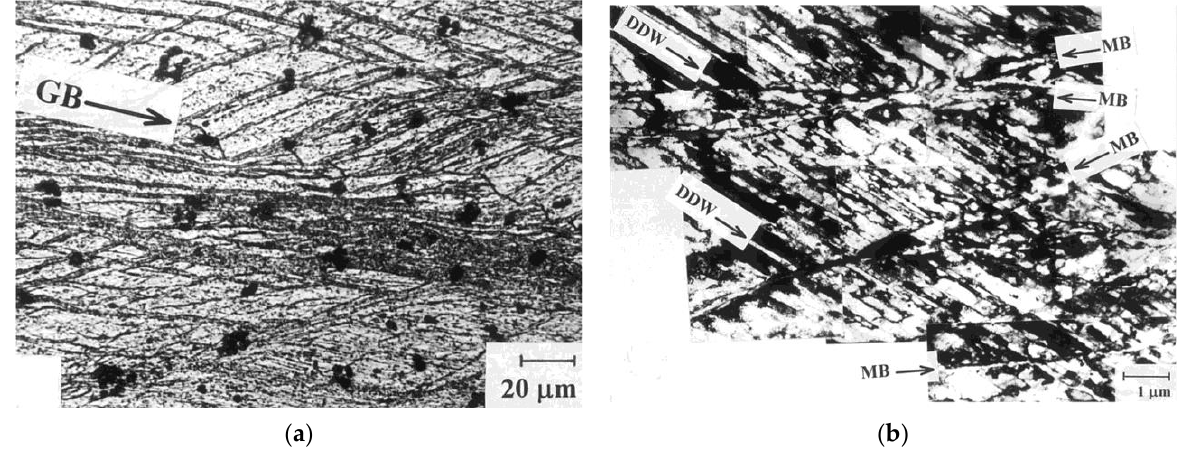
Figure 3. Microshear bands evolved near original grain boundary ( a ) and crossing dense dislocation walls ( b ) in a Fe-25%Cr steel after compression at 873 K to a strain of 0.7. Reproduced from [59], with permission from Springer Nature, 2023.